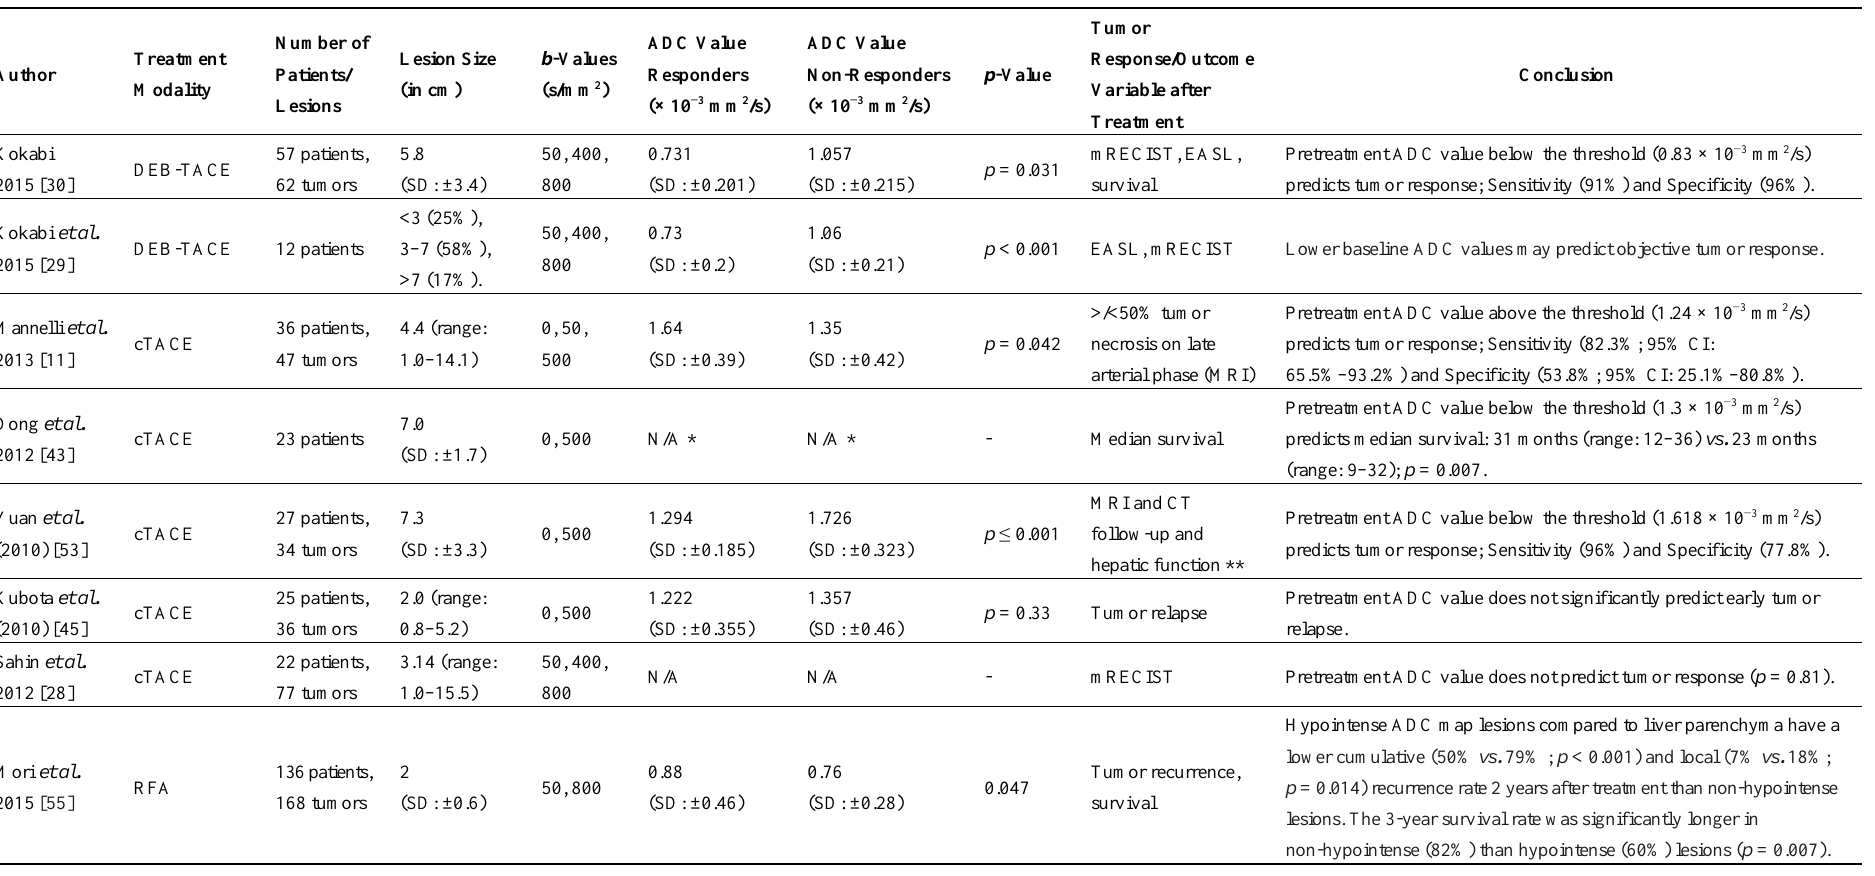
Table 1. Overview of studies with pretreatment ADC value assessment of HCC lesions for response and outcome